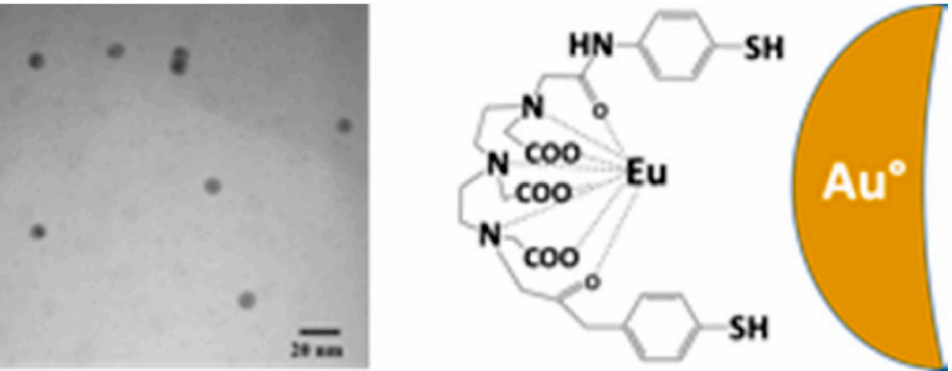
Figure 26. TEM micrographs of Au NPs of Eu (III) complexes as defined in ref. [166]. Reproduced by reference permis- sion [186], RSC, 2006.